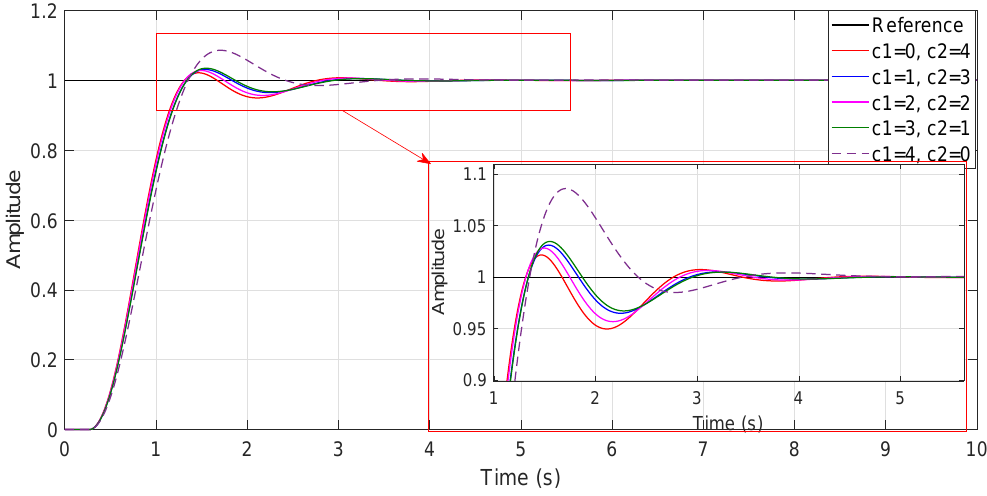
Figure 6. Obtained system responses with different acceleration